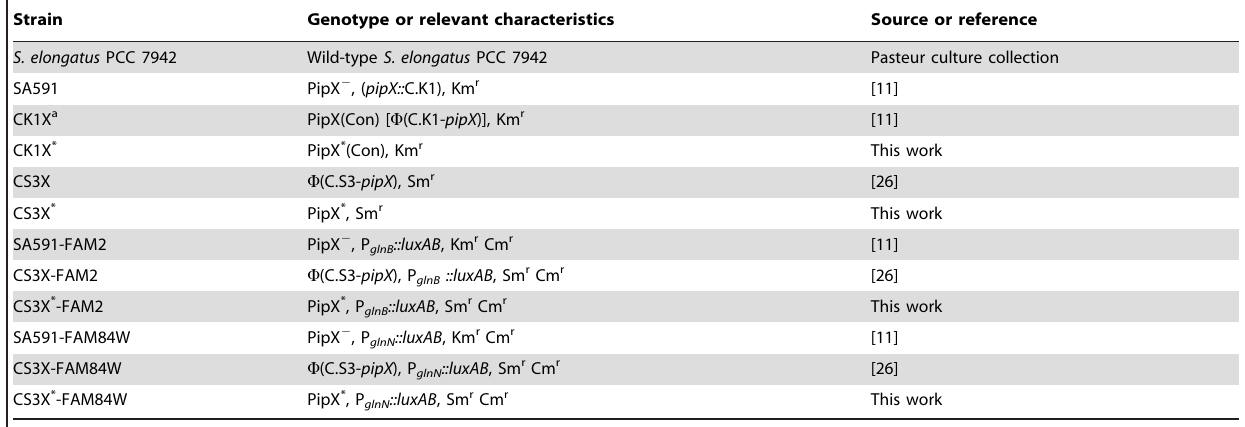
Table 1. S. elongatus strains used in this